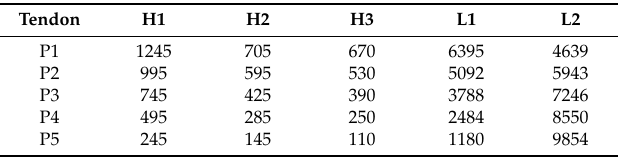
Figure 3. Geometric dimensions of prestressed tendons (unit: mm). Table 1. Mechanical properties of reinforcement steel. Table 3. Geometric parameter of prestressed tendons (unit: mm).